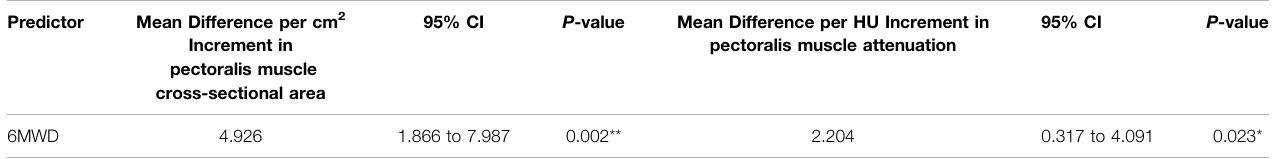
BMI,bodymassindex;6MWD,6-minute-walkdistance;COPD,chronicobstructivelungdisease;PMA,pectoralismusclecross-sectionalarea;PMT,pectoralismuscleattenuation;RB1, apical bronchus of right upper lobe; TAC, total airway count; % pred, percentage predicted; FEV1, forced expiratory volume in 1s; CI, con fi dence interval. ** p < 0.01, * p < 0.05.